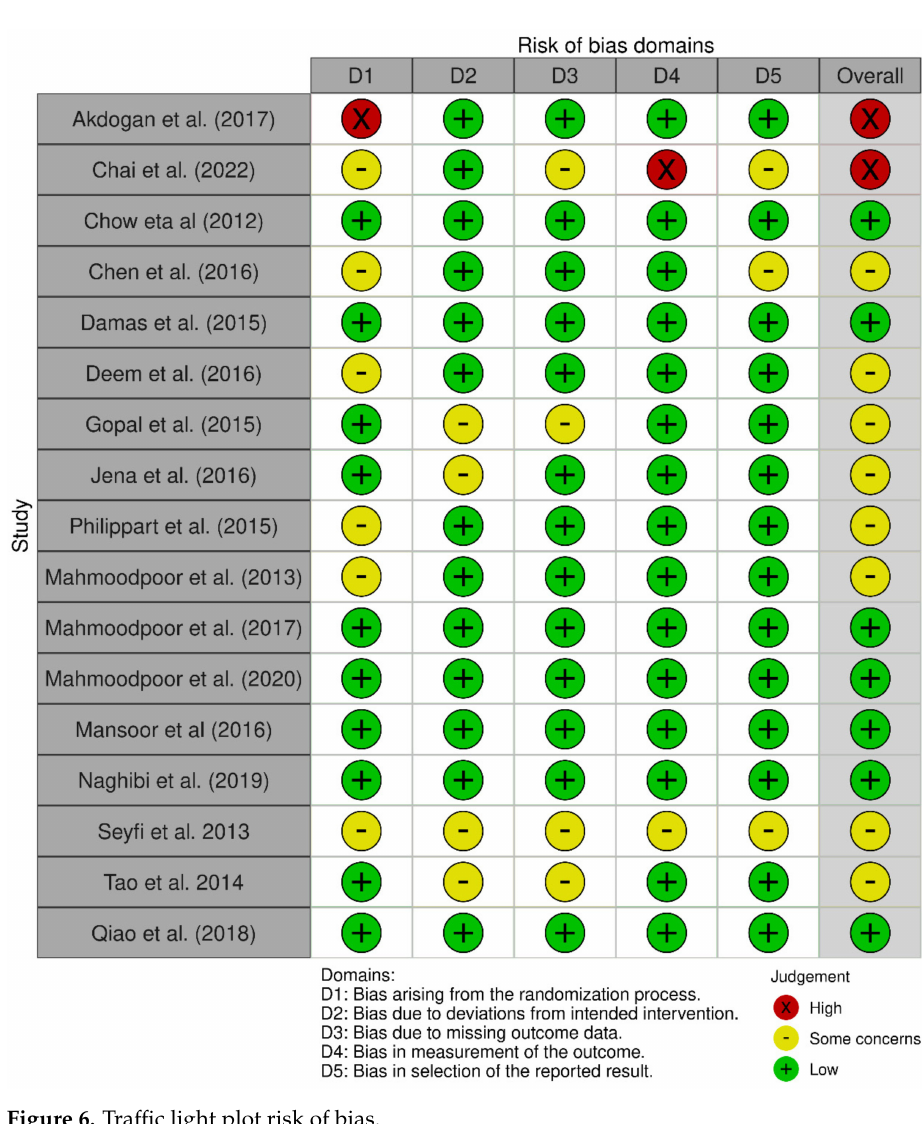
Figure 6. Traffic light plot risk of bias.